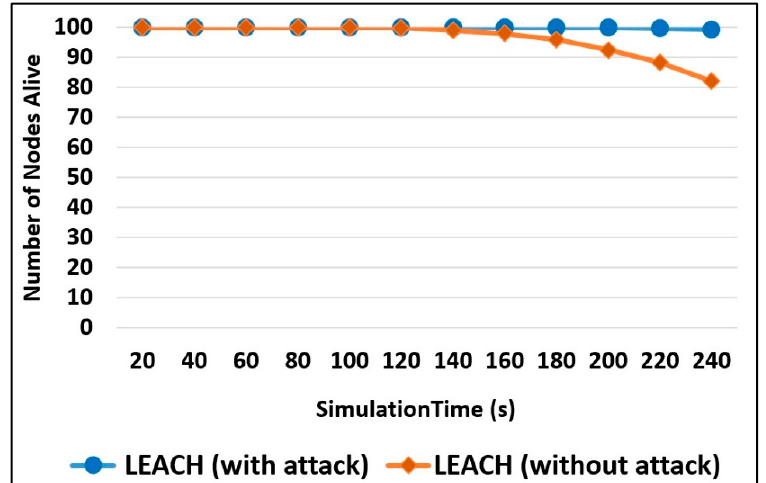
Figure 11. Number of nodes alive measurement.